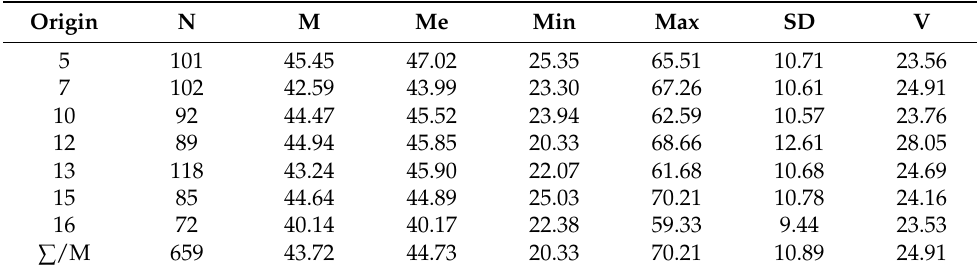
Table 2. Characteristics of compressive strength Rc (MPa) of diverse genetic origins (N—Number of groups; M—Average; Me—Median; Min—Minimum; Max—Maximum; SD—Standard deviation; V—Coefficient of